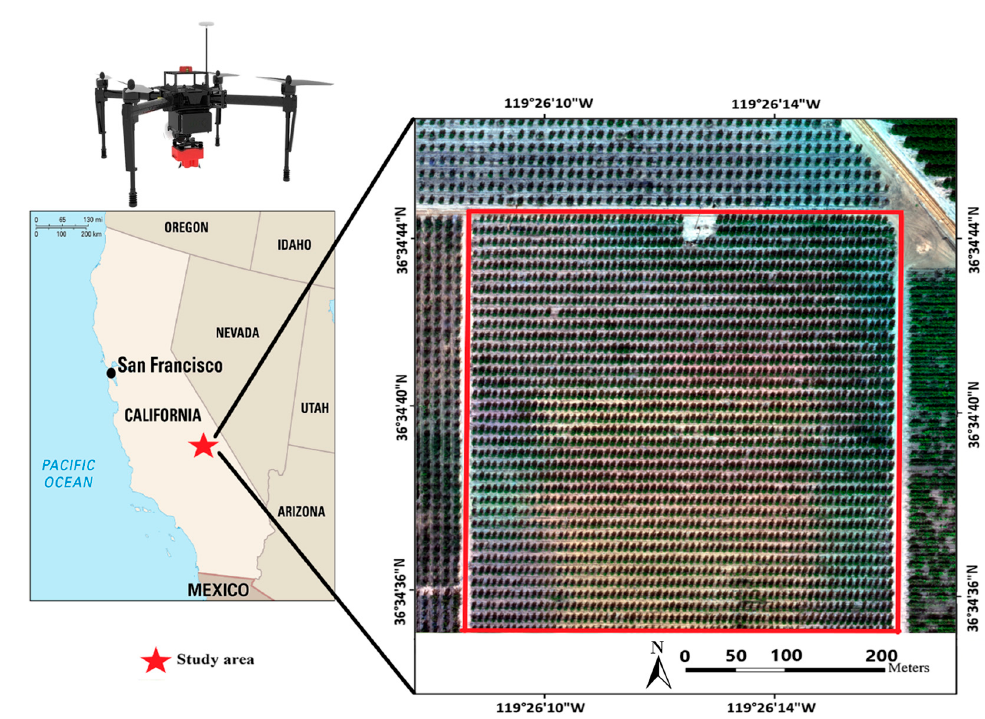
Figure 1. Study area: Multispectral map on 20 October, 2018 ( right ) of experiment. The region of interest used for analysis is outlined in red.